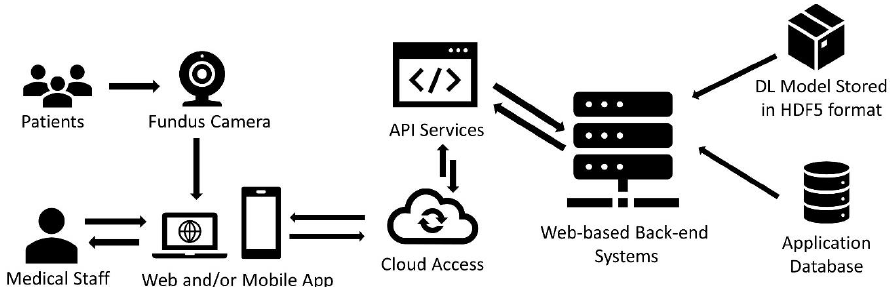
Figure 15. The architecture and workflow of early glaucoma detection platform.